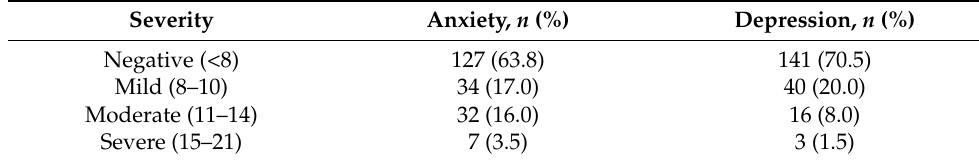
Table 3. Severity of anxiety and depression.